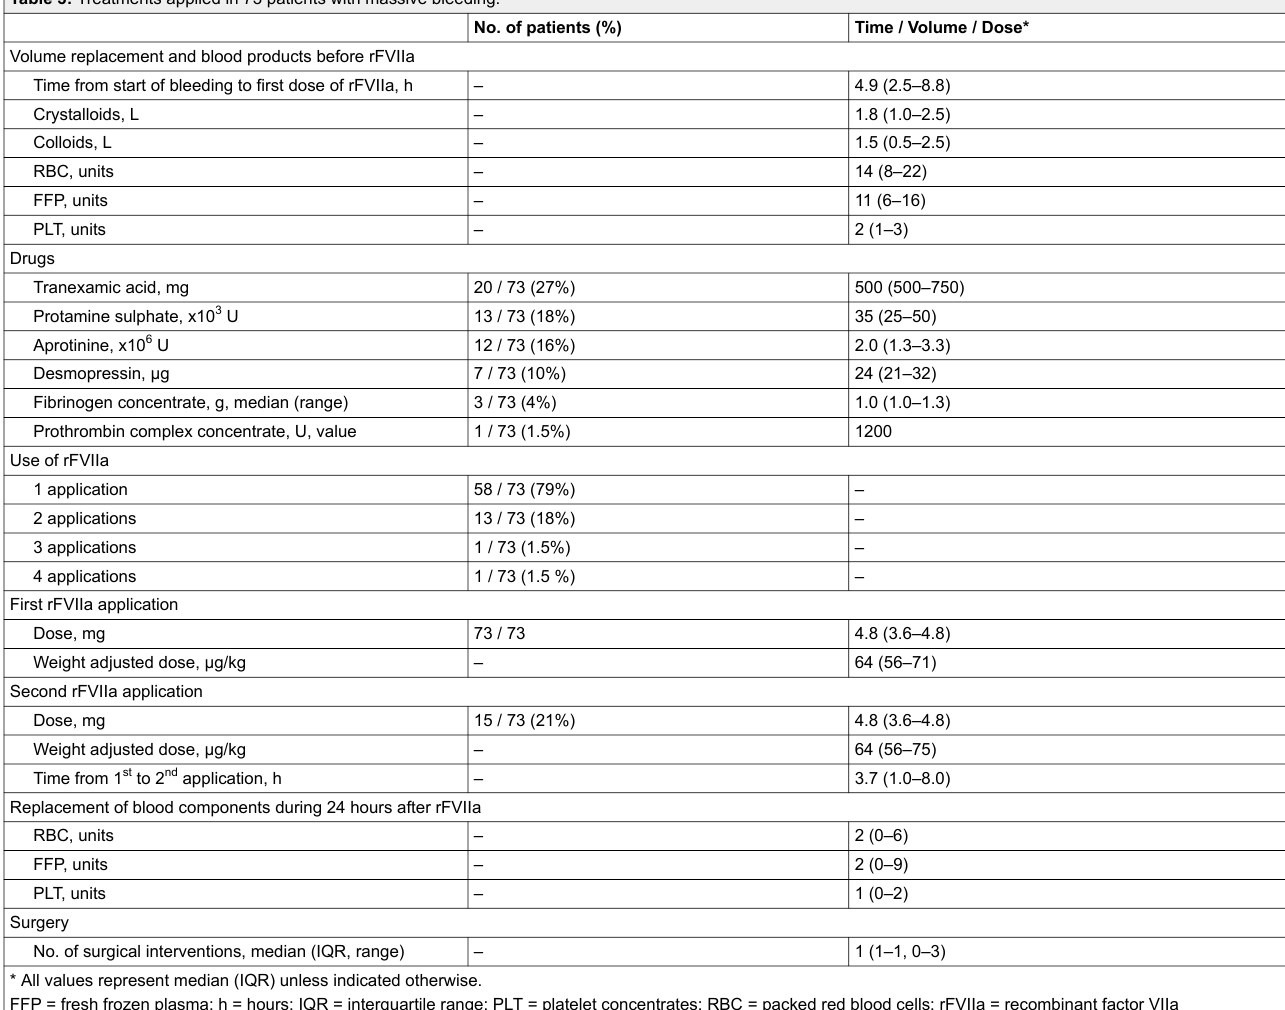
Table 3: Treatments applied in 73 patients with massive bleeding.